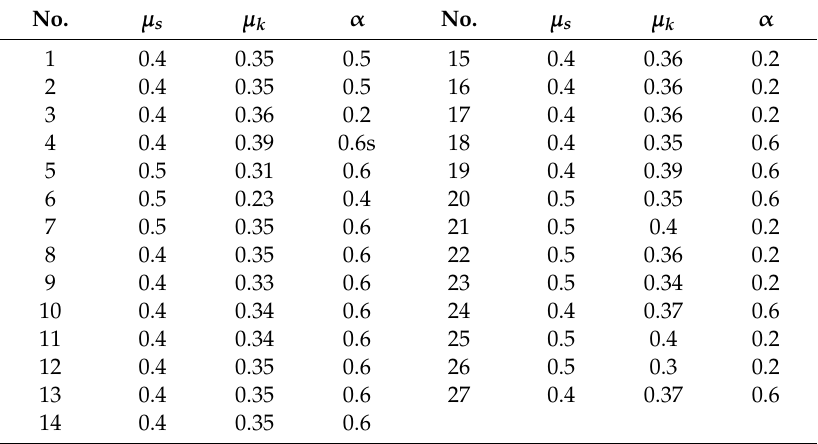
Table 2. Binary search back-calculation example